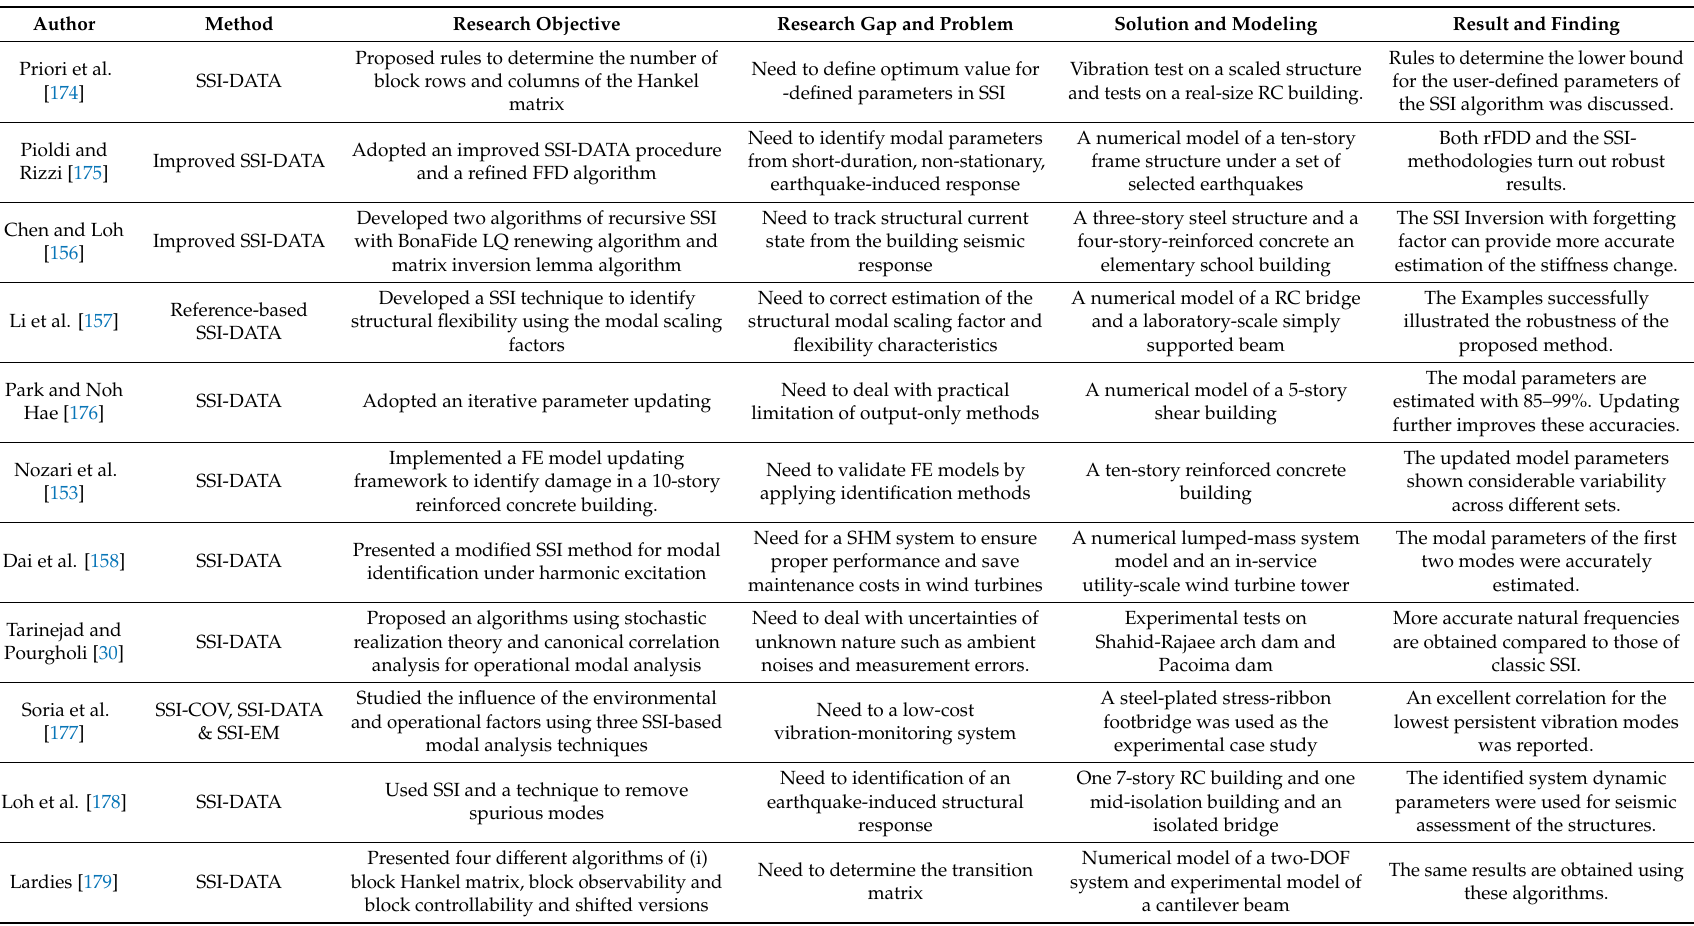
Table A1. Distribution of the papers based on SSI-DATA